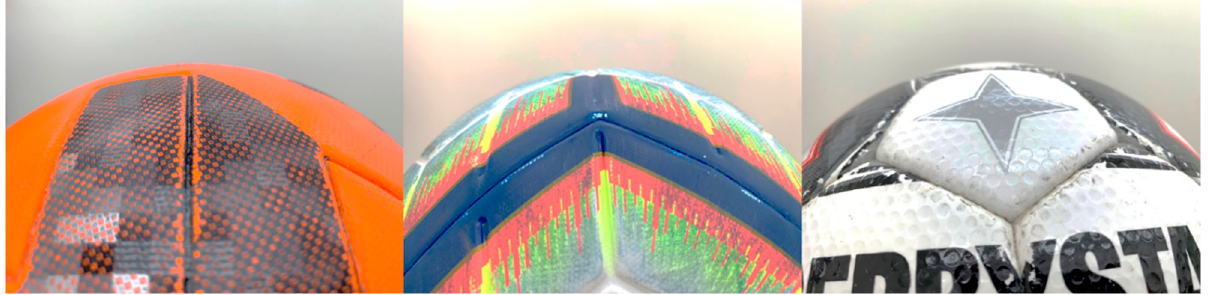
Figure 8. The surface of used soccer balls.